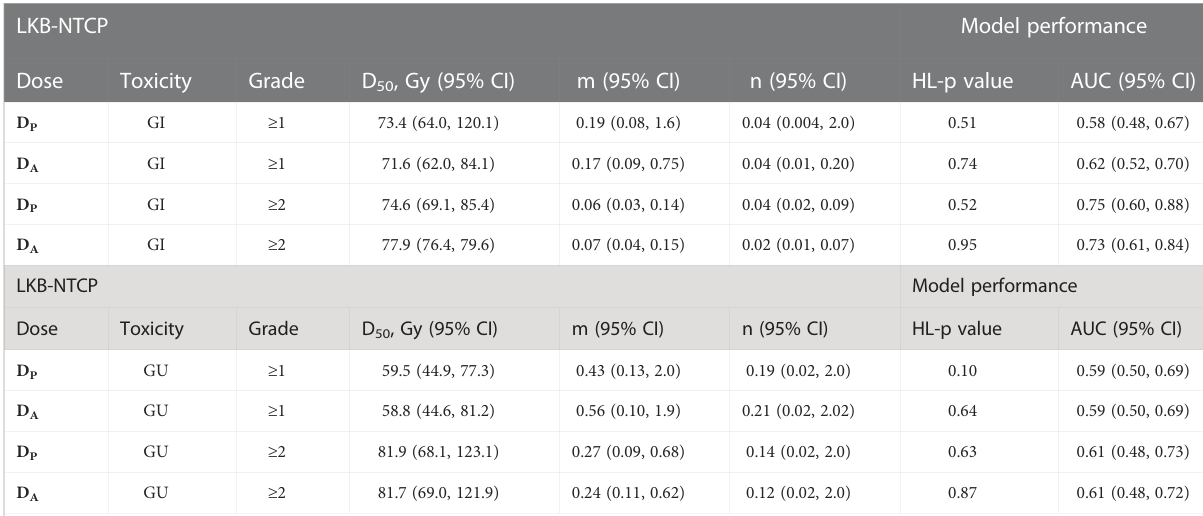
TABLE 2 Biological parameters for LKB-NTCP model fi tted with clinical endpoints using D P and D A values and associated model performance results.